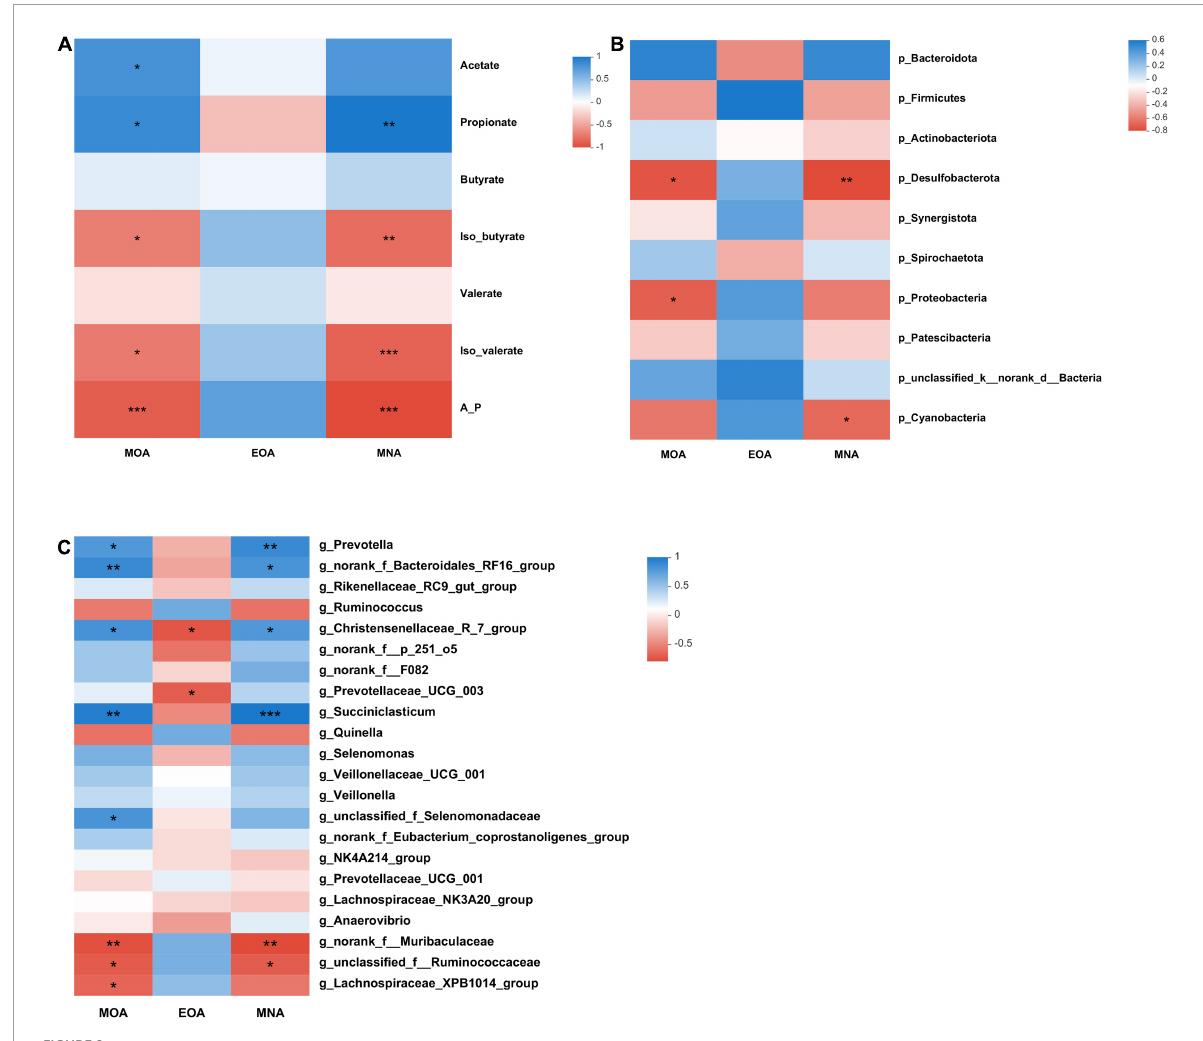
FIGURE2 Correlations between VFA contents, microbial taxa and BCFA contents (A–C) . (A) Correlation between the concentration of BCFAs and VFAs. (B) Correlation between the concentration of BCFAs and the top 10 microbial taxa at the phylum level. (C) Correlation between the concentration of BCFAs and genera with relative abundances > 1% (at least in one group). Significant correlations are shown by * P < 0.05, ** P < 0.01, and *** P < 0.001. Blue represents positive correlation coefficients. Red represents negative correlation